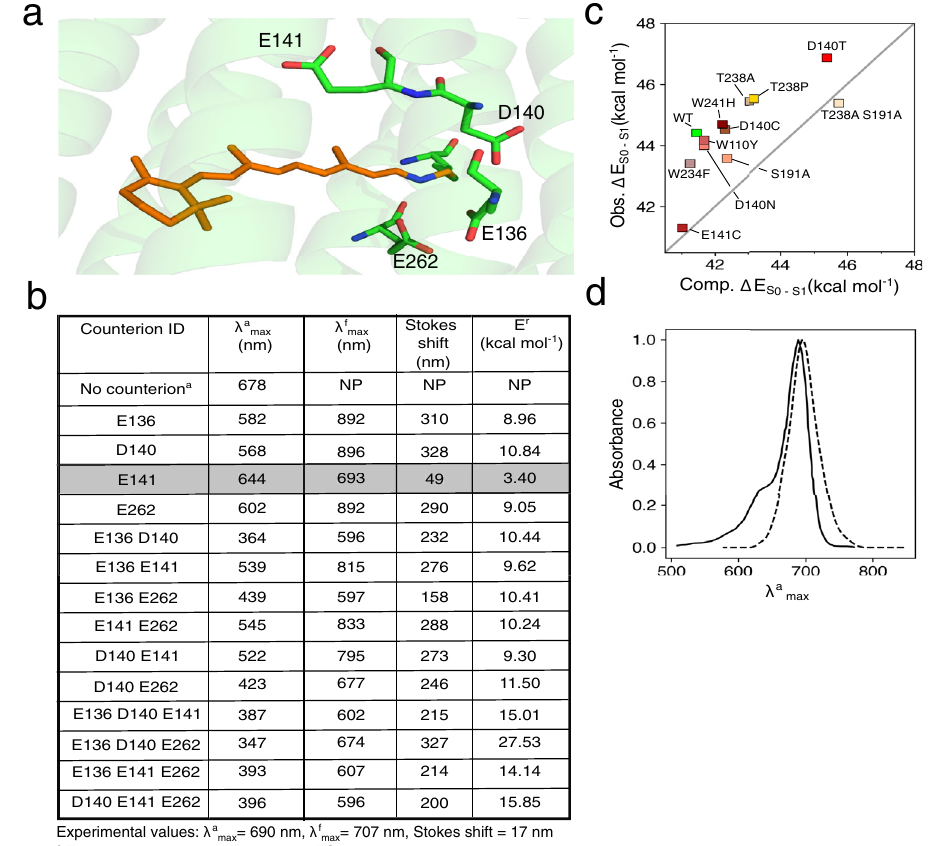
Fig. 2 | Choice of the NeoR chromophore counterion and model assessment. a Overviewofthestructureoftheall-transrPSBchromophore(orange)anditsfour potential residue counterions (in green). The lysine residue (in green) bounded to the rPSB chromophore is also displayed. b Computed (CASPT2 level) maximum absorption wavelength ( λ a max ) , maximum emission wavelength ( λ f max ) and relaxa- tion energy ( E r ) of NeoR with varying counterion choices. c Correlation between